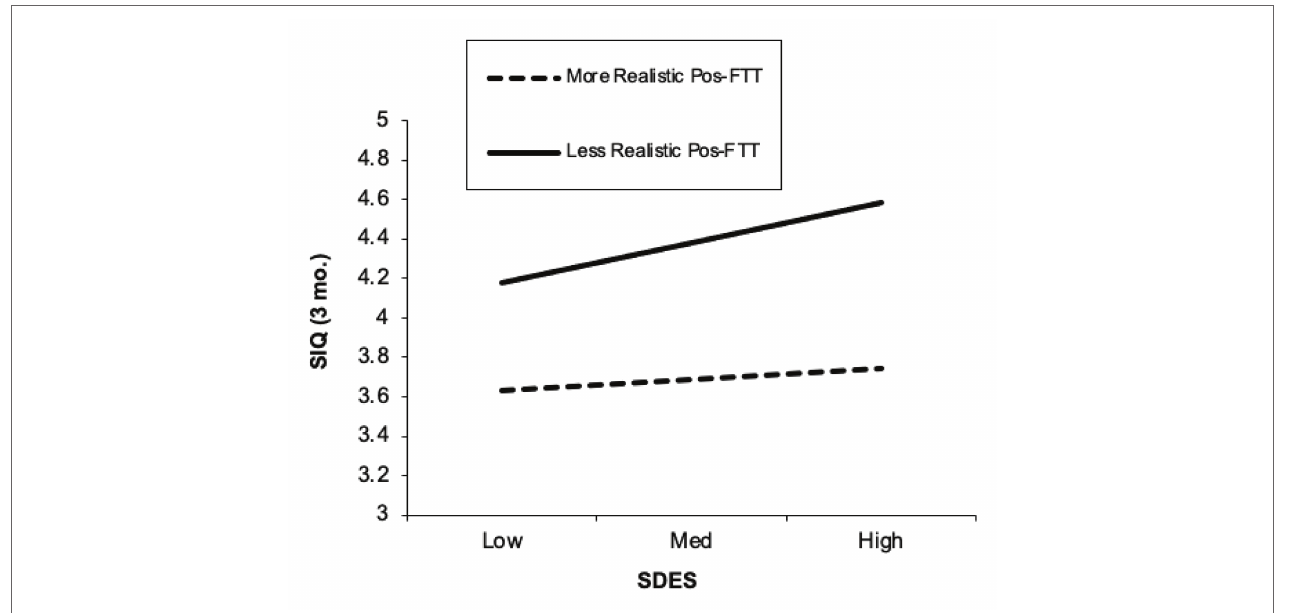
FIGURE 3 | Degree of realistic positive future thinking moderates the association between defeat/entrapment and future (3-month) suicidal ideation. SDES, Short Defeat and Entrapment Scale; SIQ, Suicide Ideation Questionnaire. More vs. less realistic positive future thinking levels (i.e., less unrealistic vs. more unrealistic) were defined as − 1 SD and + 1 SD, respectively. The SIQ scale reflects values of the transformed variable, and not raw